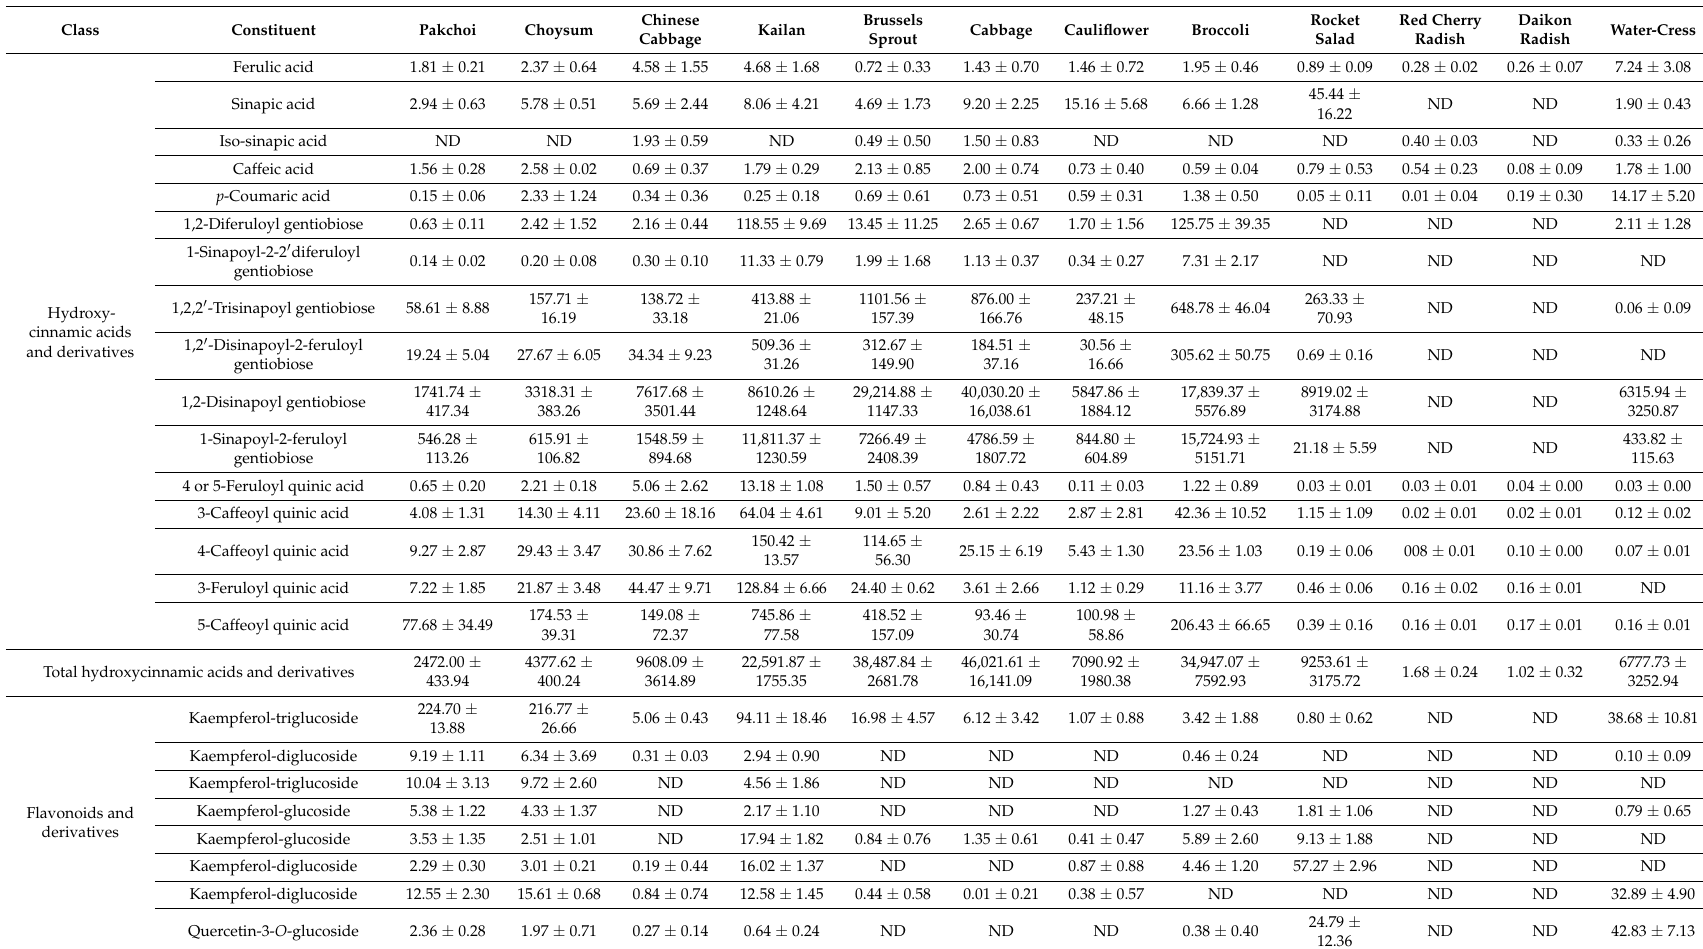
Table 1. Concentration of 74 phenolic compound in 12 cruciferous vegetables. Results were expressed as mean ± standard error of mean (SEM) in µ g/g DW. ( n = 3, ND: not